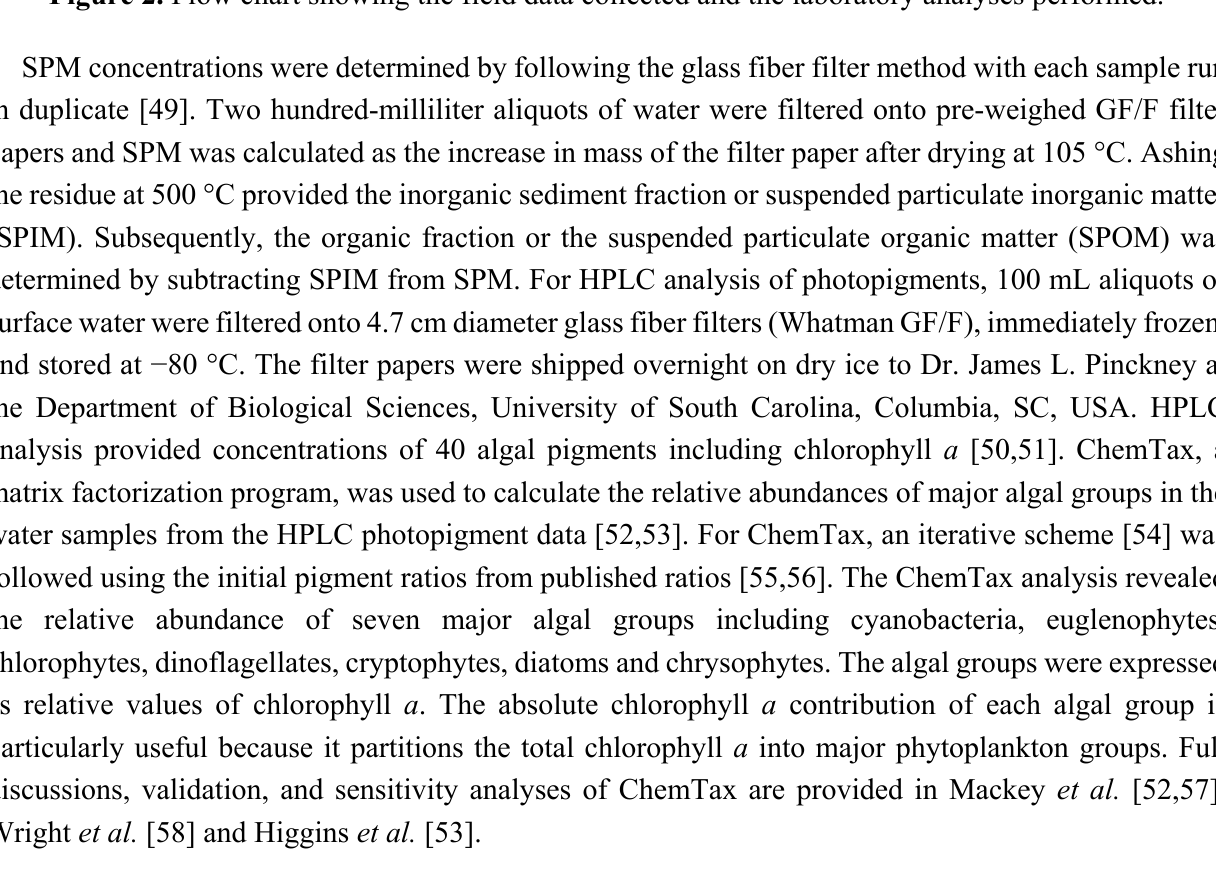
Figure 2. Flow chart showing the field data collected and the laboratory analyses